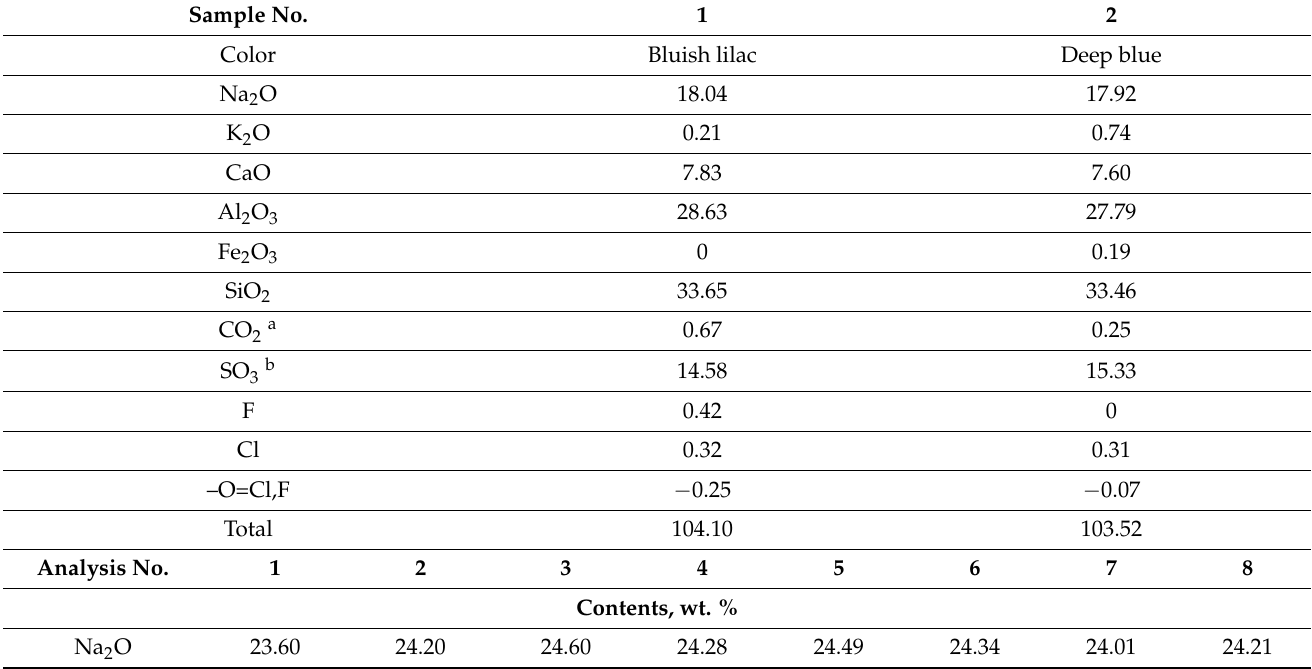
Table 1. Chemical composition (wt.%) of haüyne from the Malo-Bystrinskoe gem lazurite deposit, Baikal Lake area, Siberia, Russia obtained in this work. Representative chemical analyses of sodalite– sapozhnikovite series minerals (Sample 12) from Karnasurt Mt., Lovozero massif, Kola Peninsula, Russia obtained in this